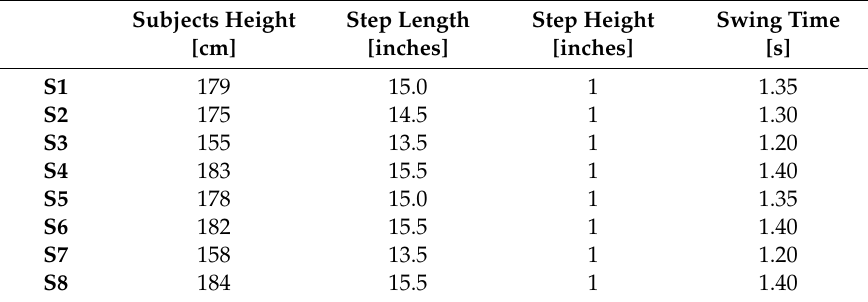
Table 2. Gait parameters for the Ekso set for each